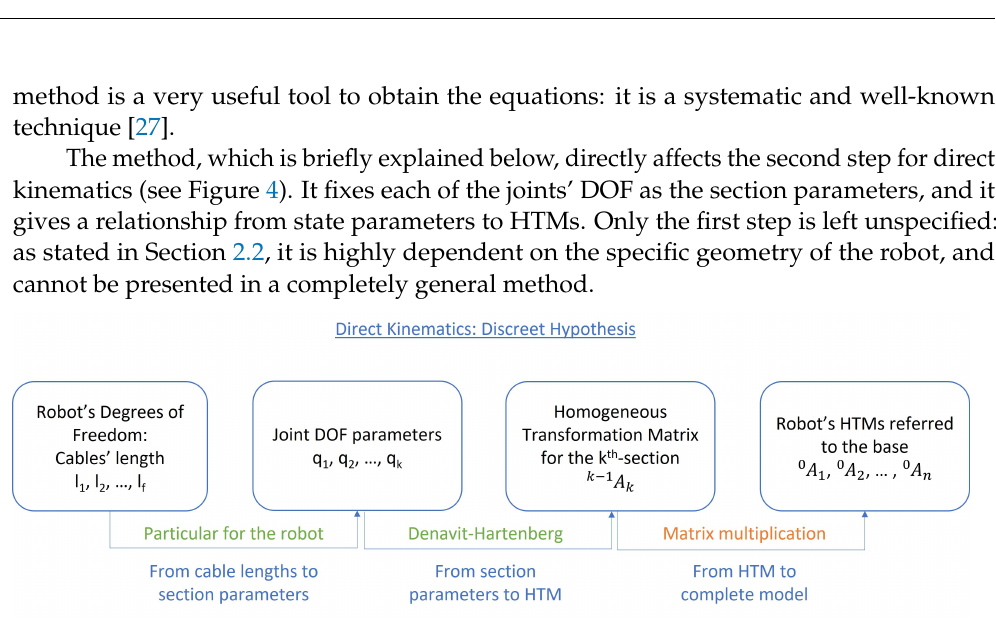
Figure 4. Direct kinematics for the discreet hypothesis.